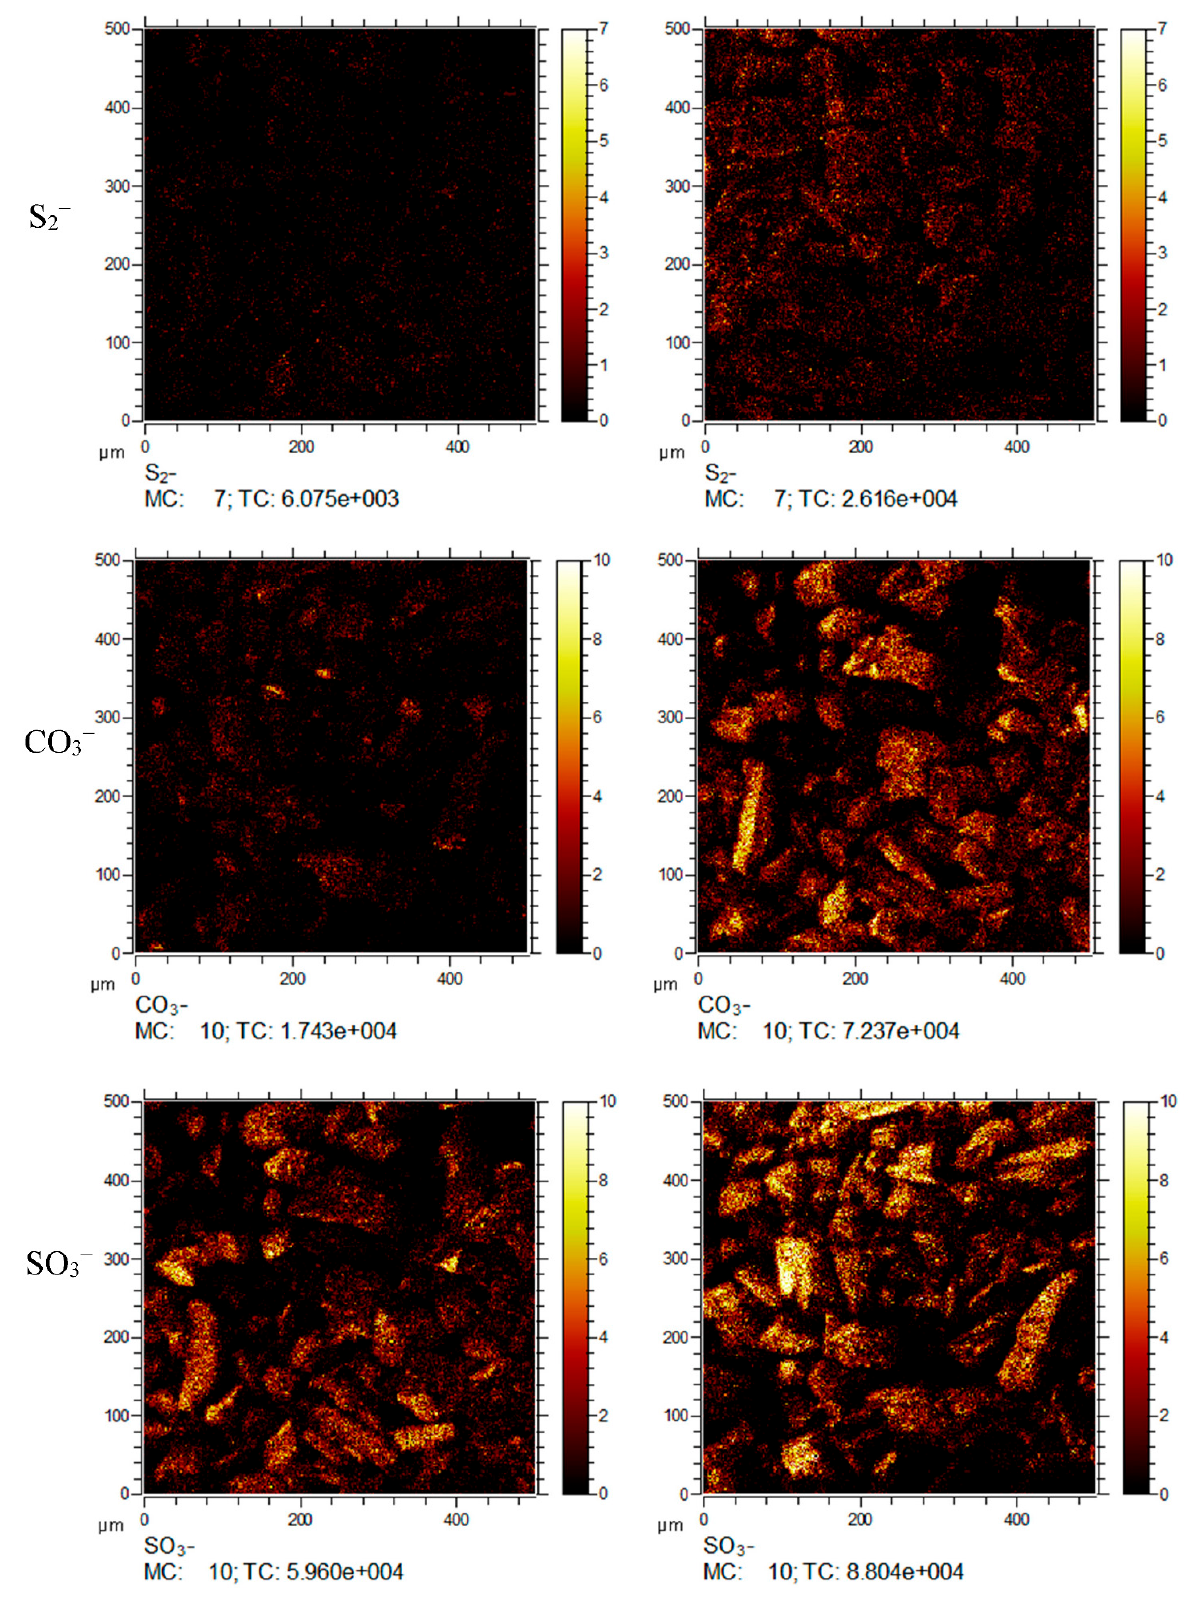
Figure 11. ToF–SIMS negative ion images of the malachite surface as follows: ( a ) treated with Na 2 S, and ( b ) treated with (NH 4 ) 2 S, Na 2 S = 6 × 10 − 2 mol/L, (NH 4 ) 2 S = 6 × 10 − 2 mol/L.